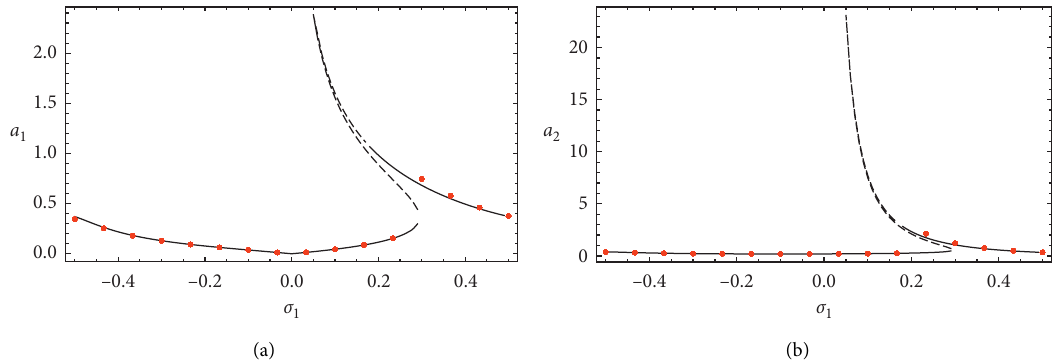
Figure 13: Frequency σ main system; (b) the